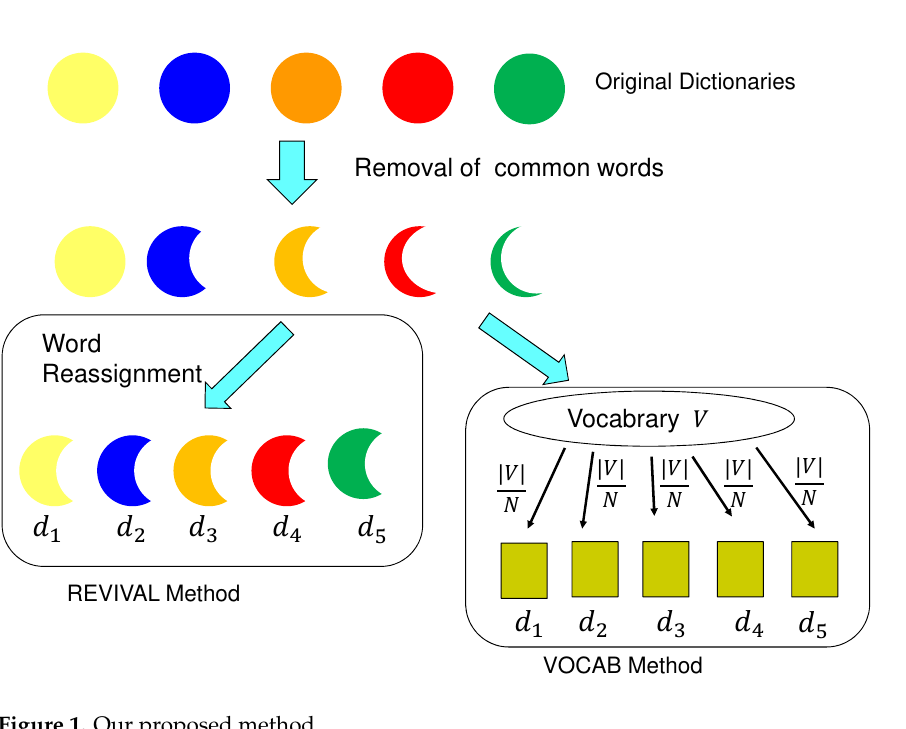
Figure 1. Our proposed